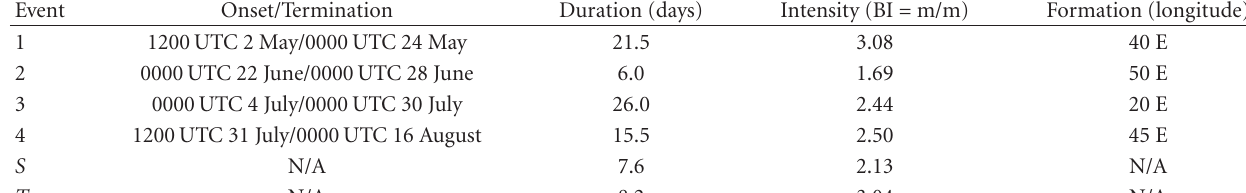
Table 2: The blocking events studied here and their characteristics such as duration, intensity, and formation longitude, where S is the mean summer season event and T is the climatological mean event from [4].